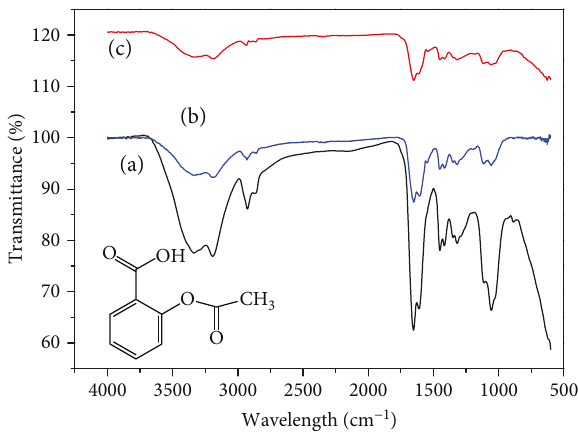
Figure 1: Infrared spectrum of (a) HEC/PAAm xerogel, (b) HEC/PAAm xerogel with ASA incorporated by swelling, and (c) HEC/PAAm xerogel with ASA incorporated on